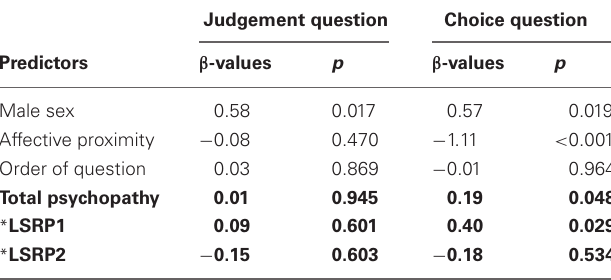
Table 2 | Regression analyses demonstrating associations between utilitarian responses to moral dilemma and